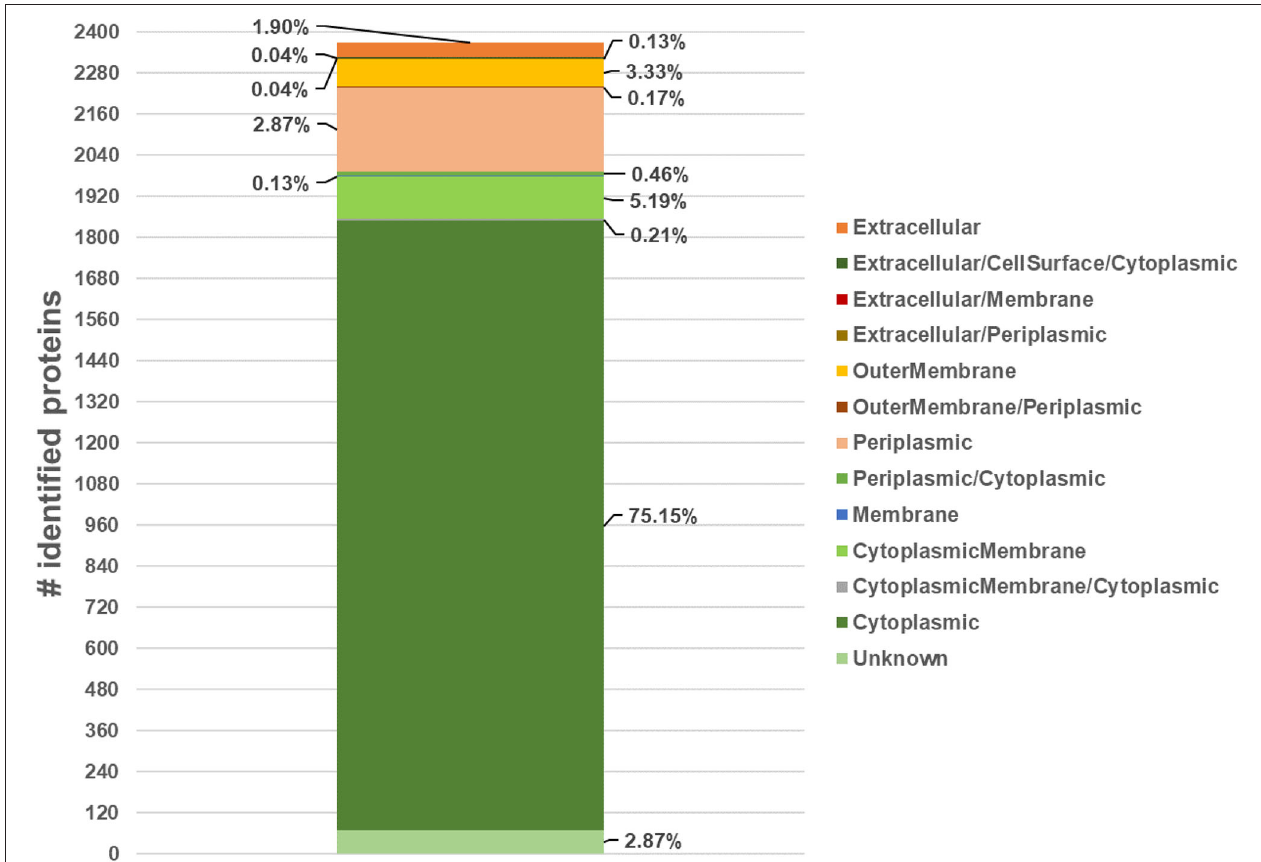
FIGURE 3 | Number of quantified proteins and their subcellular localization, expressed as percentage respect to the total number of quantified proteins, by merging data from several web-based applications (PSORTb-3.0, SignalP-5.0, TargetP-2.0, LipoP 1.0 CELLO v.2.5, SecretomeP-2.0, TOPCONS, TMHMM-2.0, DeepTMHMM, UniProtKB database and Proteome Discoverer ProteinCenter annotation). switch protein FliM (Q51465) were under-expressed in MDR